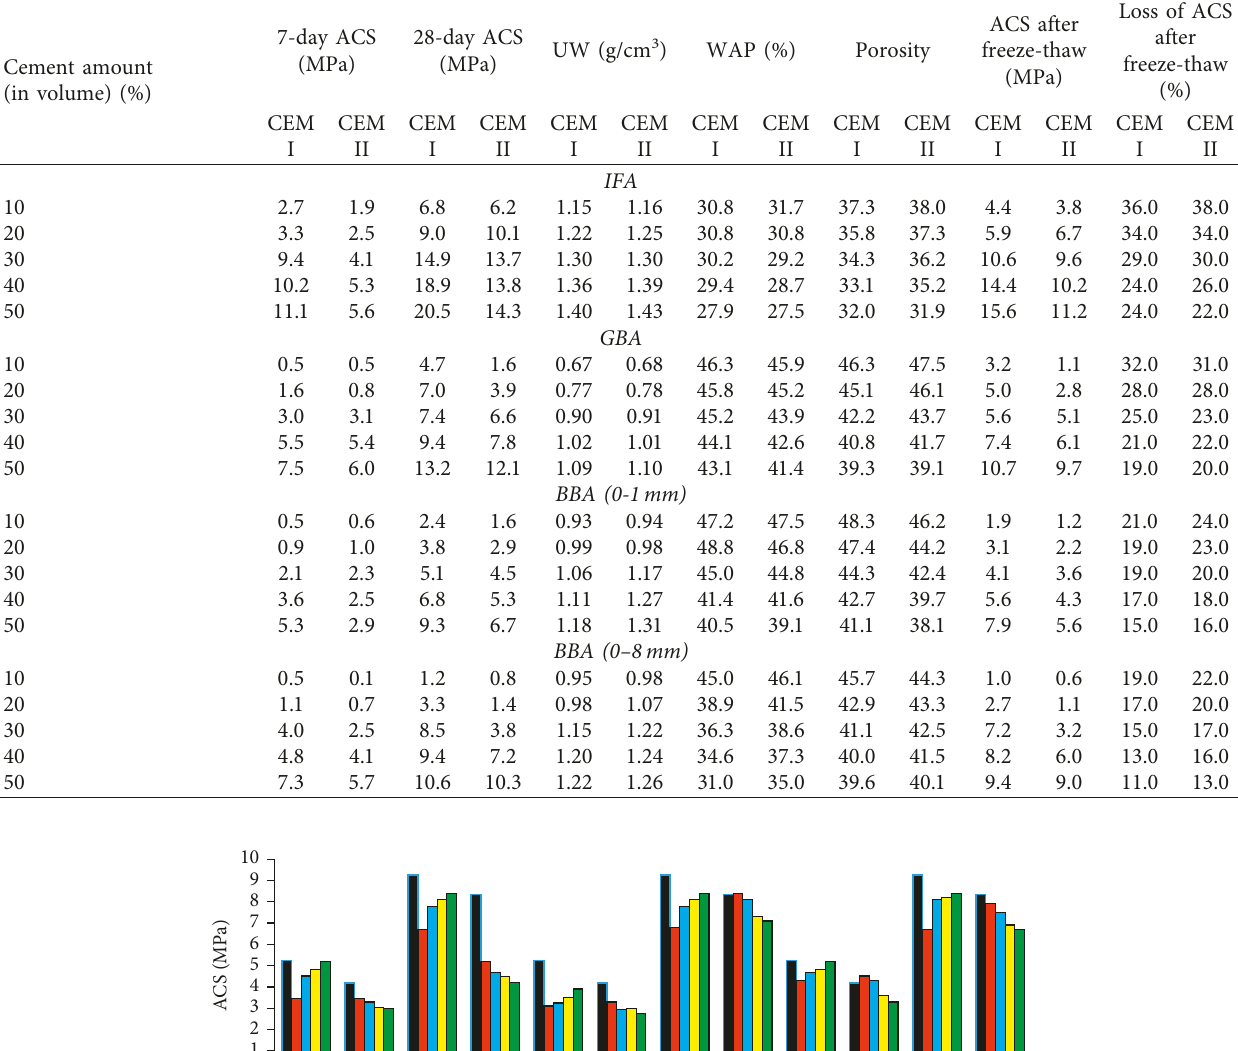
Table 3: Experimental results of ash-based lightweight materials.